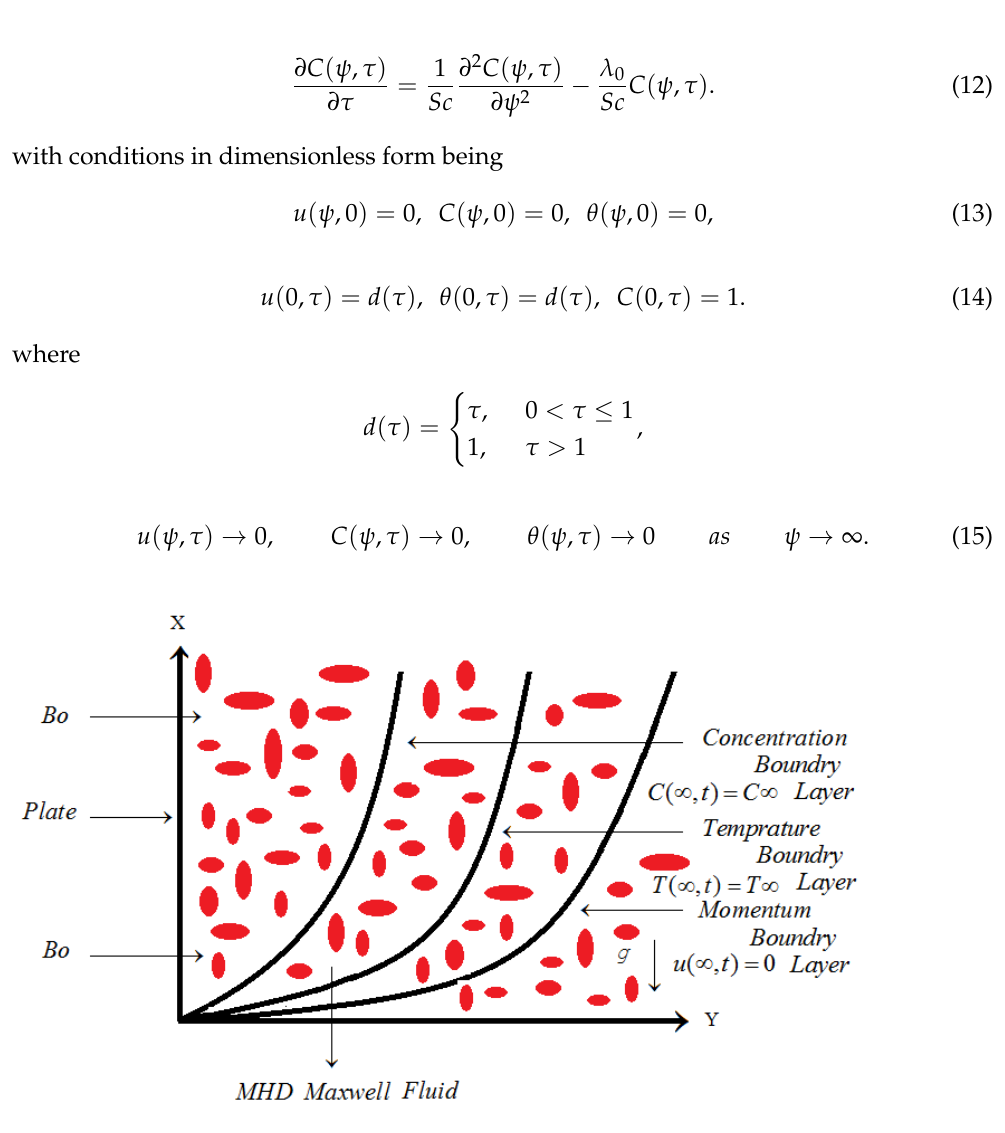
Figure 1. Geometrical formation of the flow